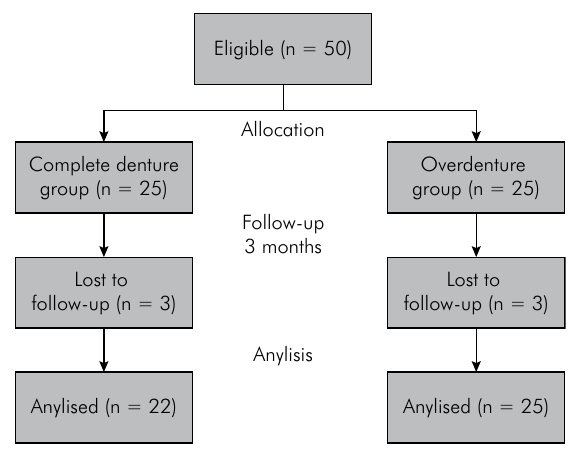
Figure 1. Study flow